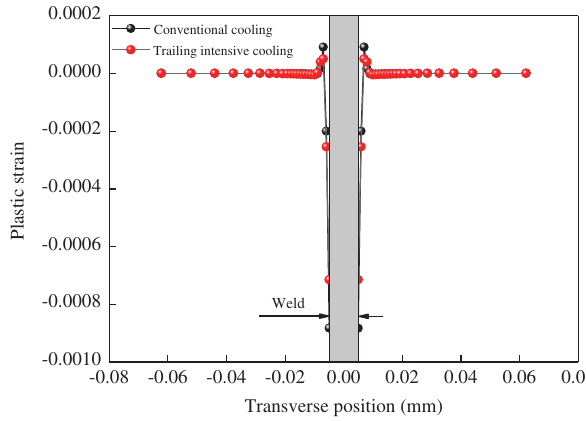
Figure 8: Distribution of plastic strain of the outside points of weld.